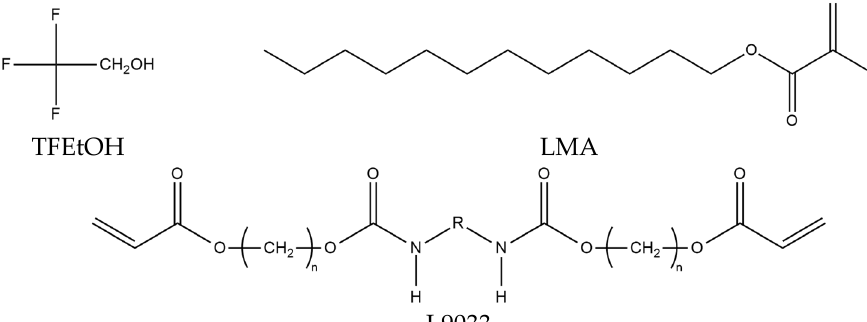
Figure 1. Chemical structures of selected components.